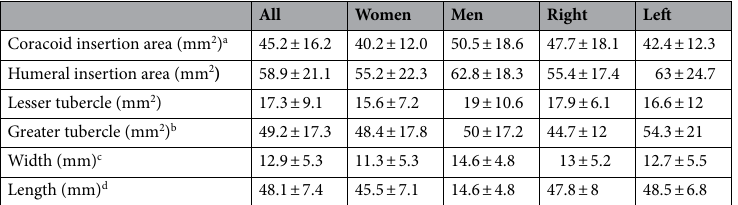
Table 1. Morphology of the CHL. a Significant difference between females and males ( p = 0.045). b Strong correlation between total insertion area and area on greater tubercle r = 0.940, p < 0.001. c Significant difference between females and males ( p = 0.049). d Significant difference between females and males ( p = 0.17).